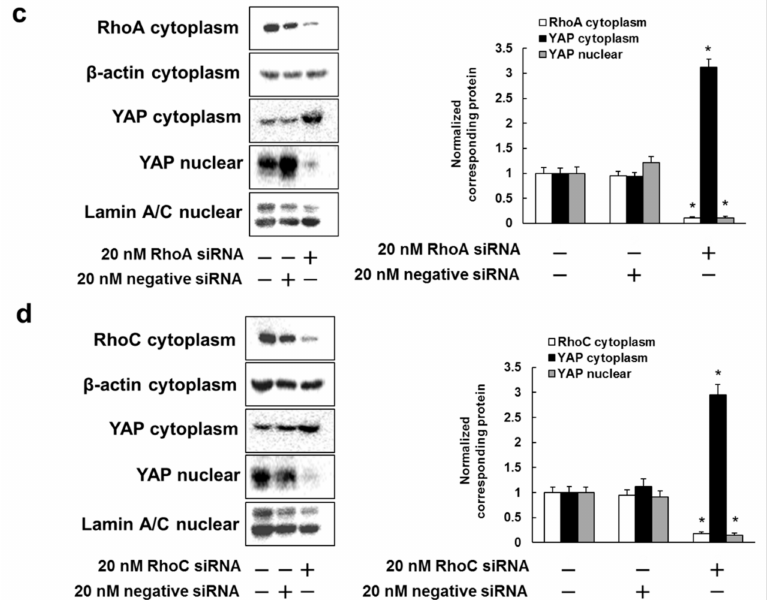
Figure 2. Rhosin inhibits RhoA/C-YAP pathway in B16BL6 and 4T1 cells: ( a ) B16BL6 and 4T1 cells were treated with rhosin at indicated concentration for 3 days. Images of Western blots for the RhoA pull-down, RhoA, RhoC pull-down, RhoC, phospho-ERK1/2, ERK1/2, phospho-Akt, Akt, phospho- NF- κ B, NF- κ B, YAP, β -actin, and lamin A/C; ( b ) Quantification of the amounts of RhoA